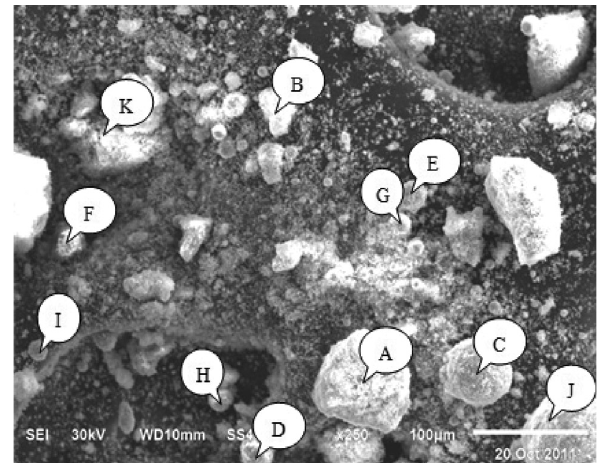
Fig. 2: SEM image of ZnO-bearing stainless steelmaking